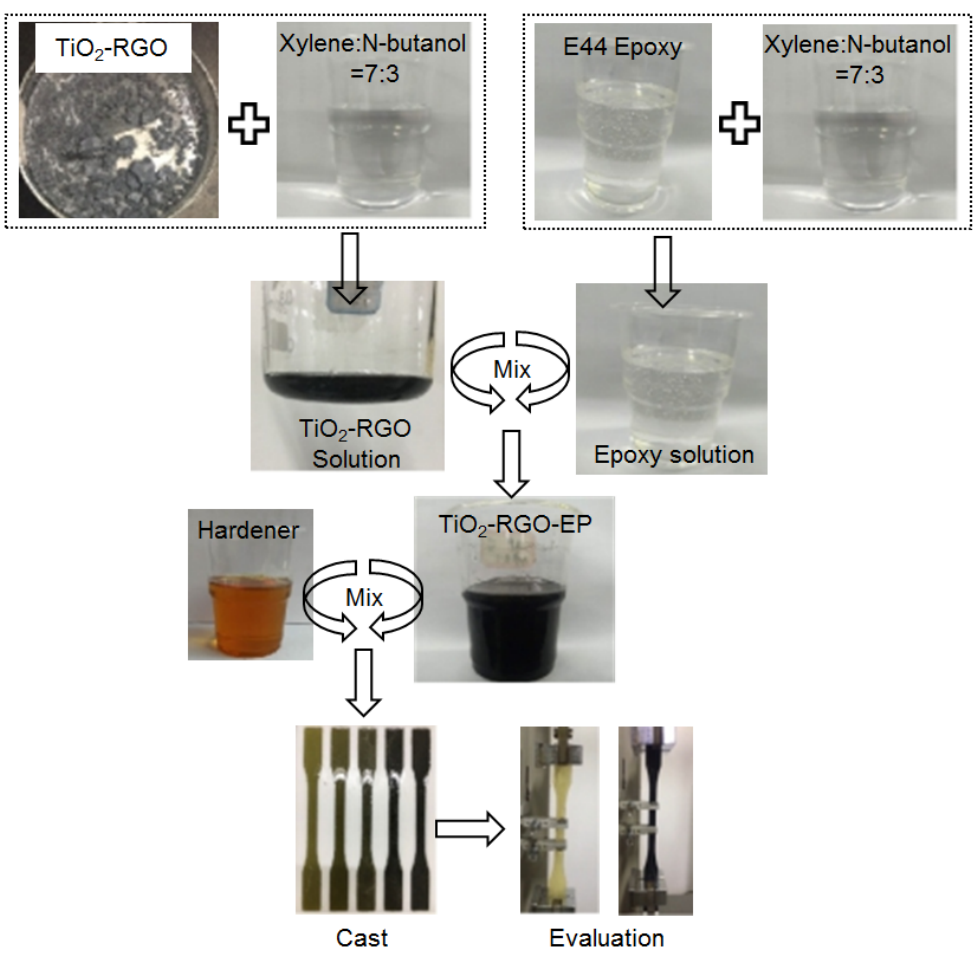
2 -RGO-EP composites. Figure 2. Schematic diagram for the preparation of TiO